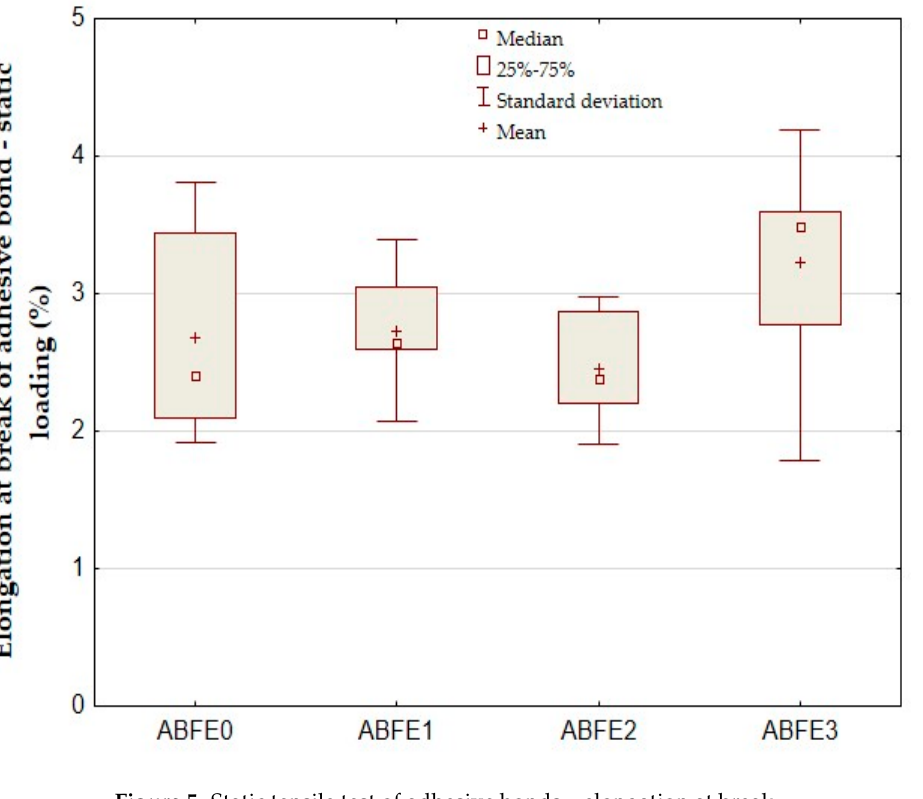
Figure 5. Static tensile test of adhesive bonds—elongation at break.